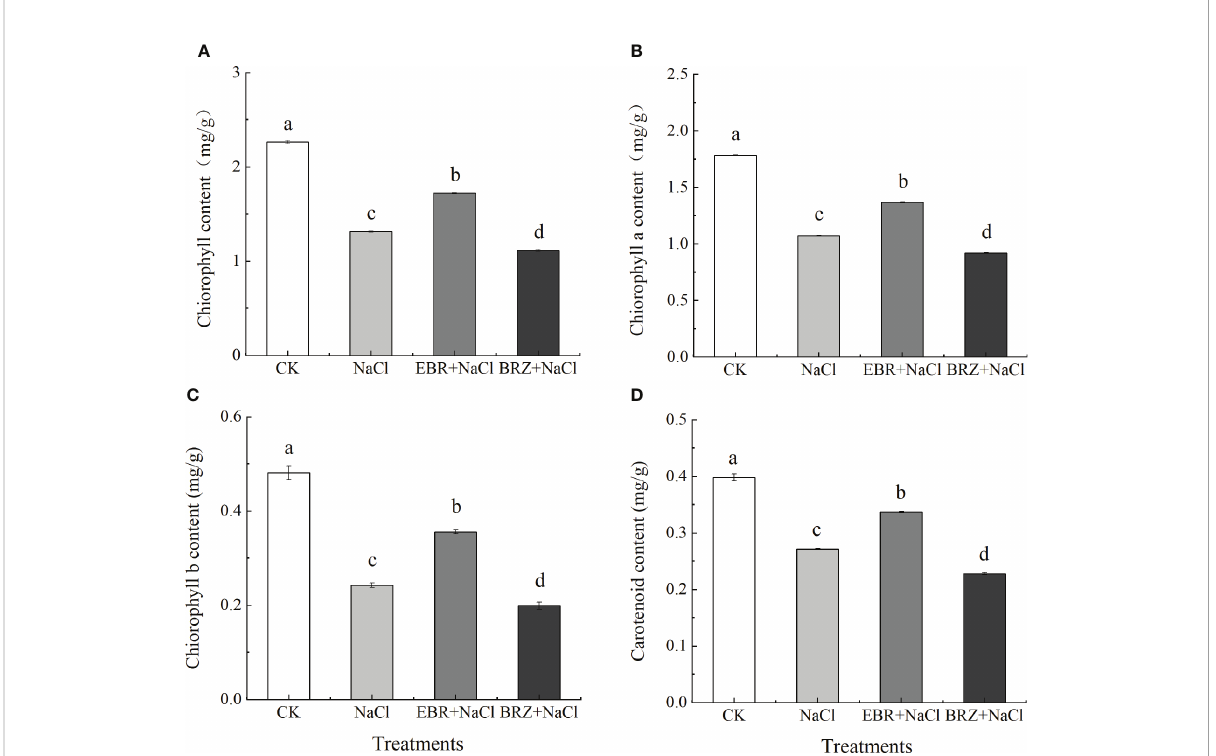
FIGURE 3 Effect of exogenous EBR on total chlorophyll content (A) , chlorophyll a (B) , chlorophyll b (C) , and carotenoid (D) content in leaves of cucumber seedlings under salt stress. Each value is the mean of three independent experiments, Data indicate the mean ± SE ( n = 3). Signi fi cances were tested within the same day by one-way ANOVA. Different letters indicate signi fi cant differences ( P <